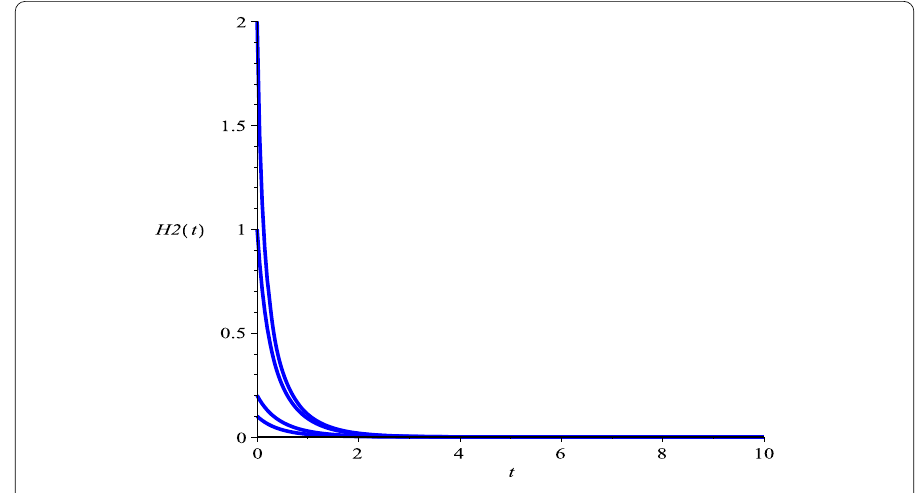
Figure 5 Dynamic behaviors of the weak partners in system (5.3). The initial conditions ( H